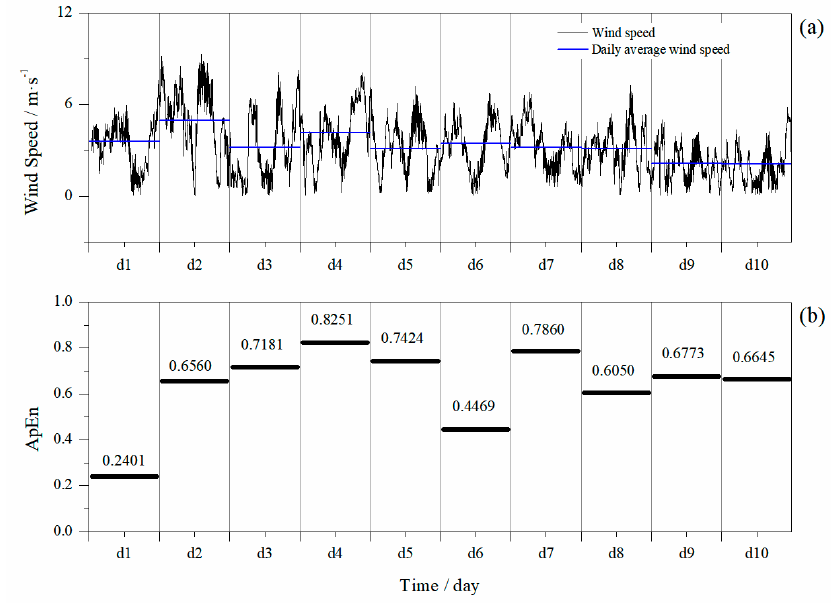
Figure 6. ( a ) The observed wind speed and ( b ) the ApEn values of daily sequence changing with time. Note: The time interval of wind speed is 1 s for displaying, while the ApEn value has been calculated for the original data with the time interval of 0.1 s.